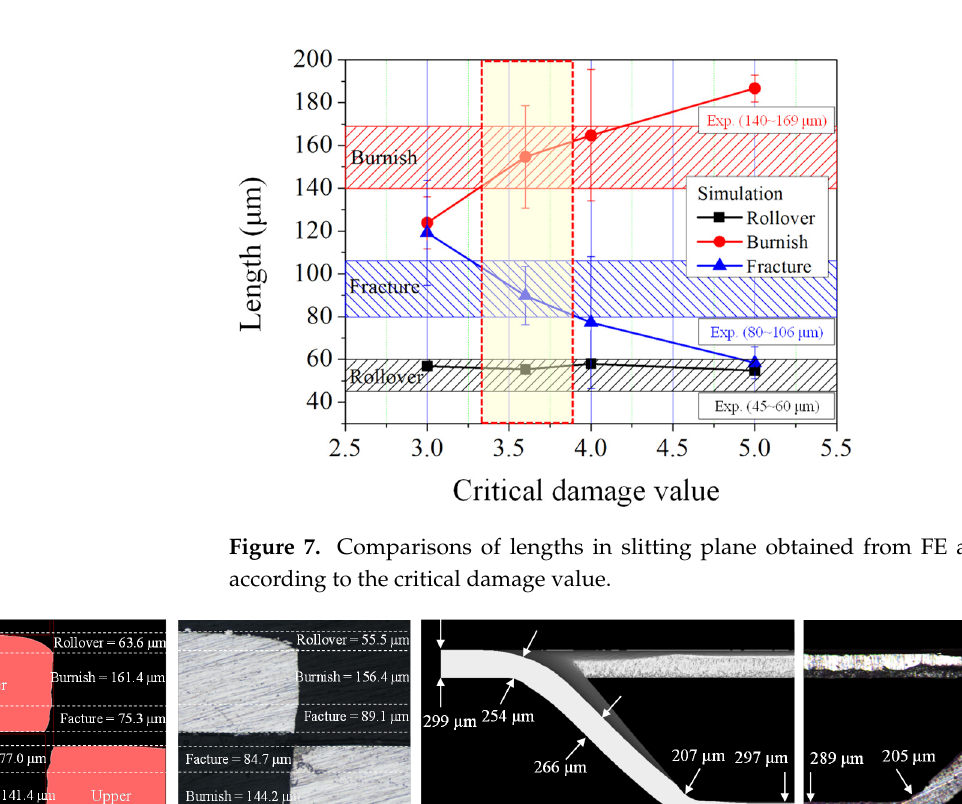
Figure 7. Comparisons of lengths in slitting plane obtained from FE analysis and experiment ac- cording to the critical damage value.